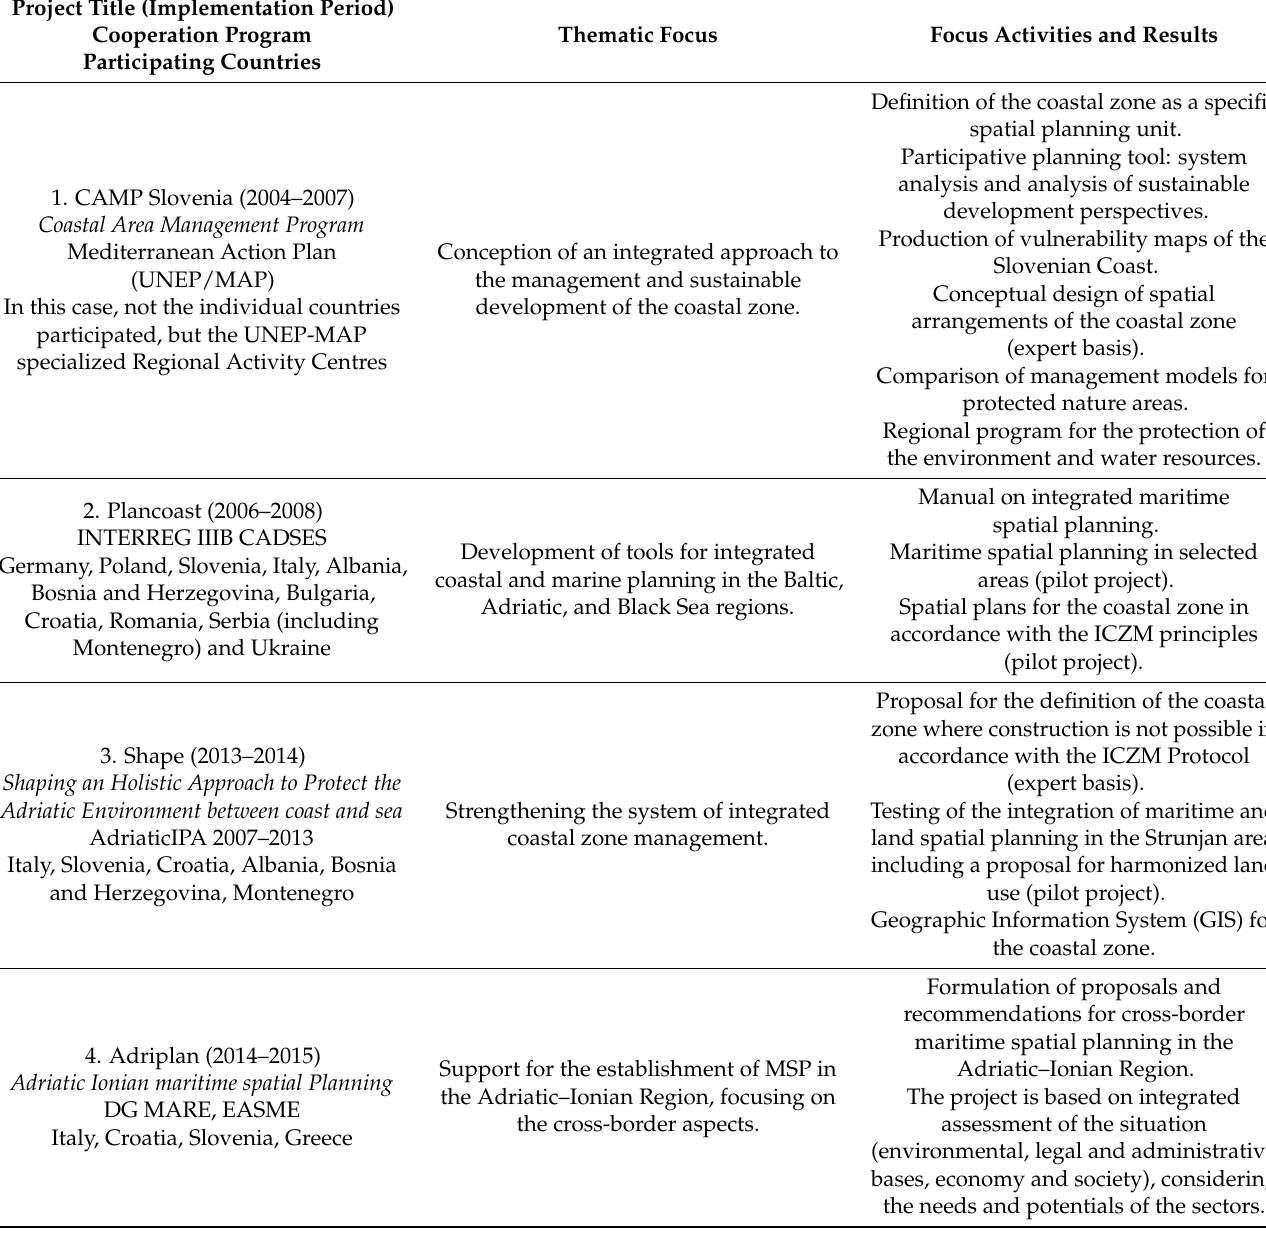
Table 1. A list and the content outline of key international projects implemented also in